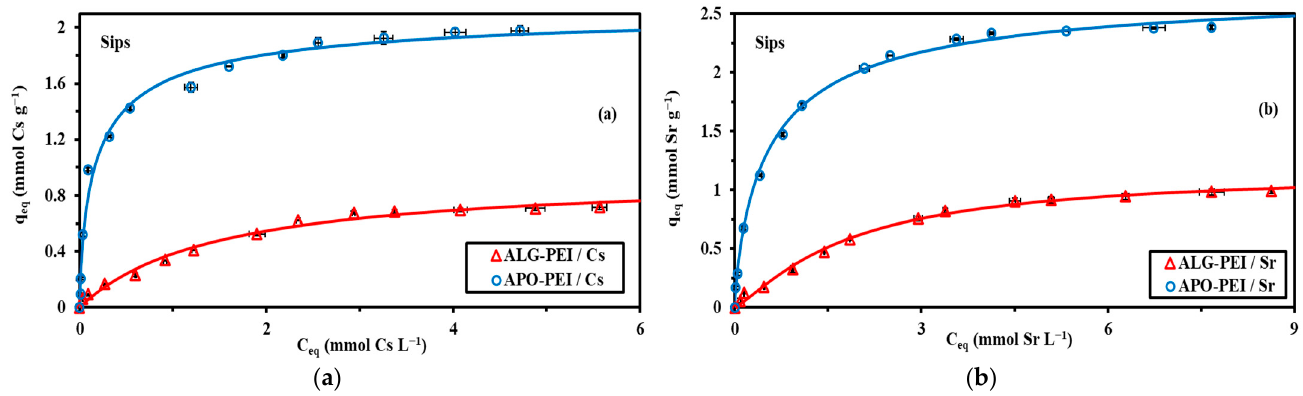
Figure 4. Sorption isotherms for Cs(I) ( a ) and Sr(II) ( b ) using ALG-PEI and APO-PEI sorbents: modeling with Sips equation (pH 0 : 7; C 0 : 0.08–6.11 mmol Cs L − 1 or 0.12–9.32 mmol Sr L − 1 ; SD: 0.67 g L − 1 ; v: 210 rpm; time: 48 h; t: 21 ± 1 ◦